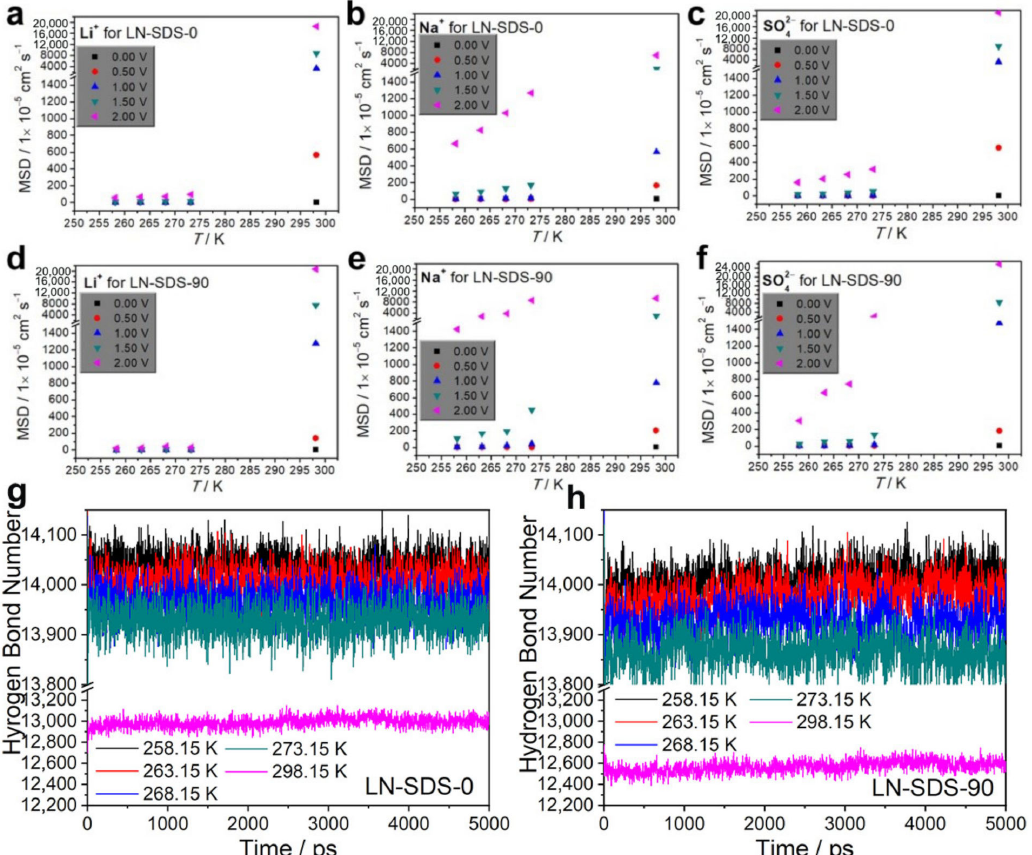
Figure 4. ( a – f ) MSD results for LN-SDS-0 and LN-SDS-90 at temperatures of 298.15–258.15 K, without and with applying voltages of 0.5–2 V nm − 1 , and HBNs of water in LN-SDS-0 ( g ) and LN-SDS-90 ( h ) at temperatures of 298.15–258.15 K, applying a voltage of 2 V nm − 1